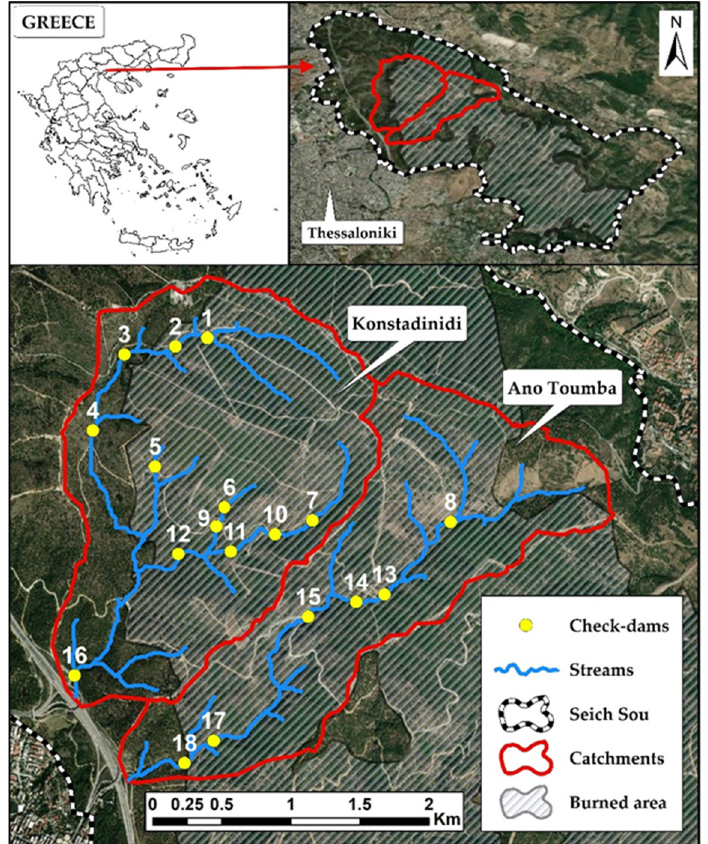
Figure 1. Study area. Thessaloniki suburban forest (Seich Sou) and the location of the constructed check-dams in Konstadinidi and Ano Toumba catchments.